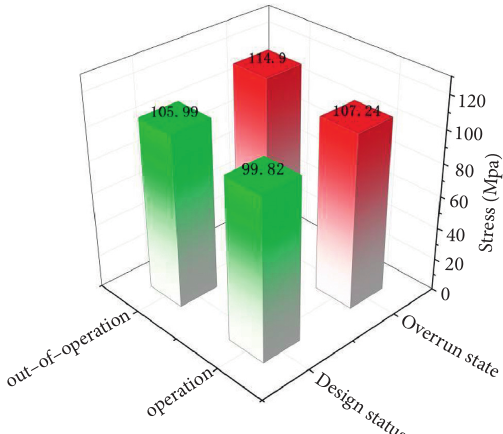
Figure 9: Stress of the lattice columns in the vertical state and inclined state.